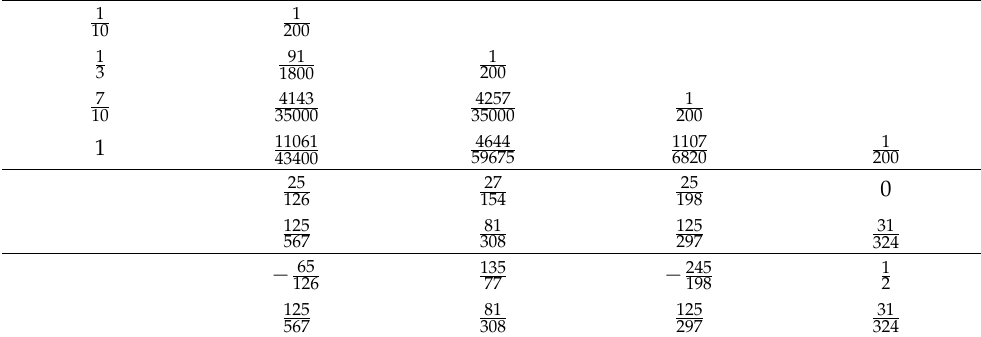
Table 1. Coefficients of the DIRKN5(4)4D